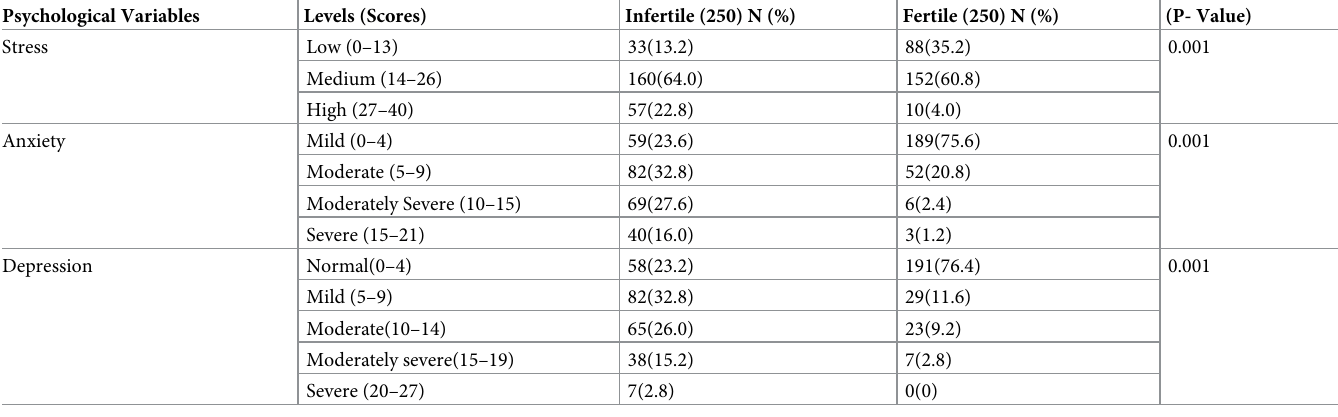
Table 2. Distribution of stress, anxiety, and depression among infertile and fertile women. Psychological